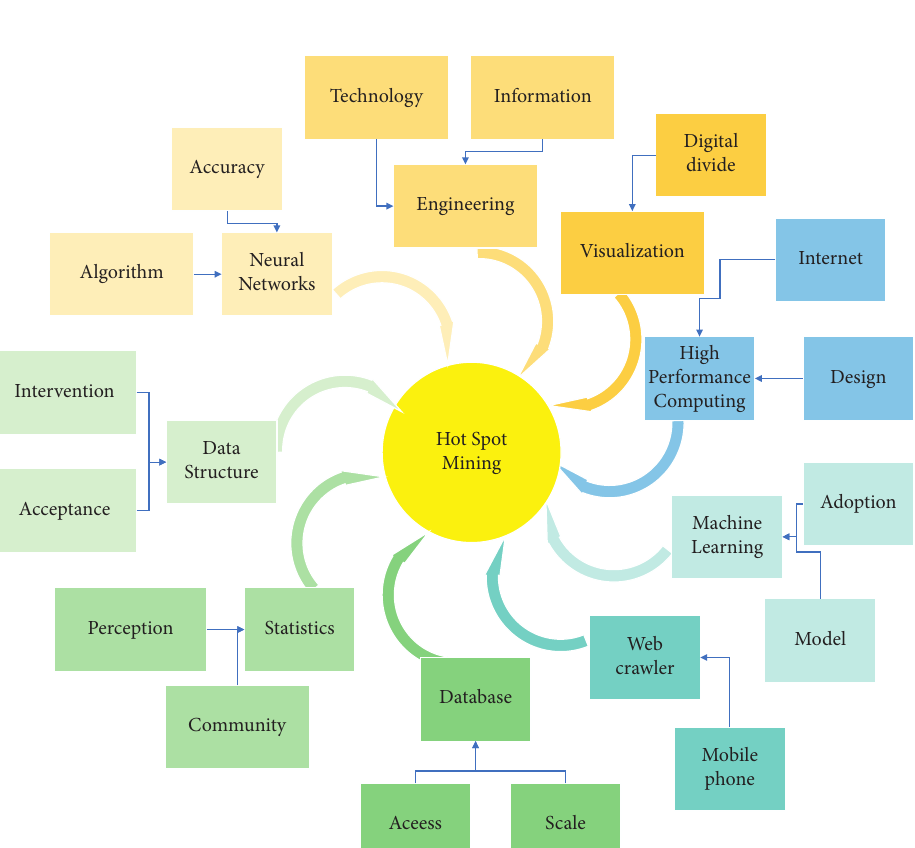
Figure 1: LDA probability